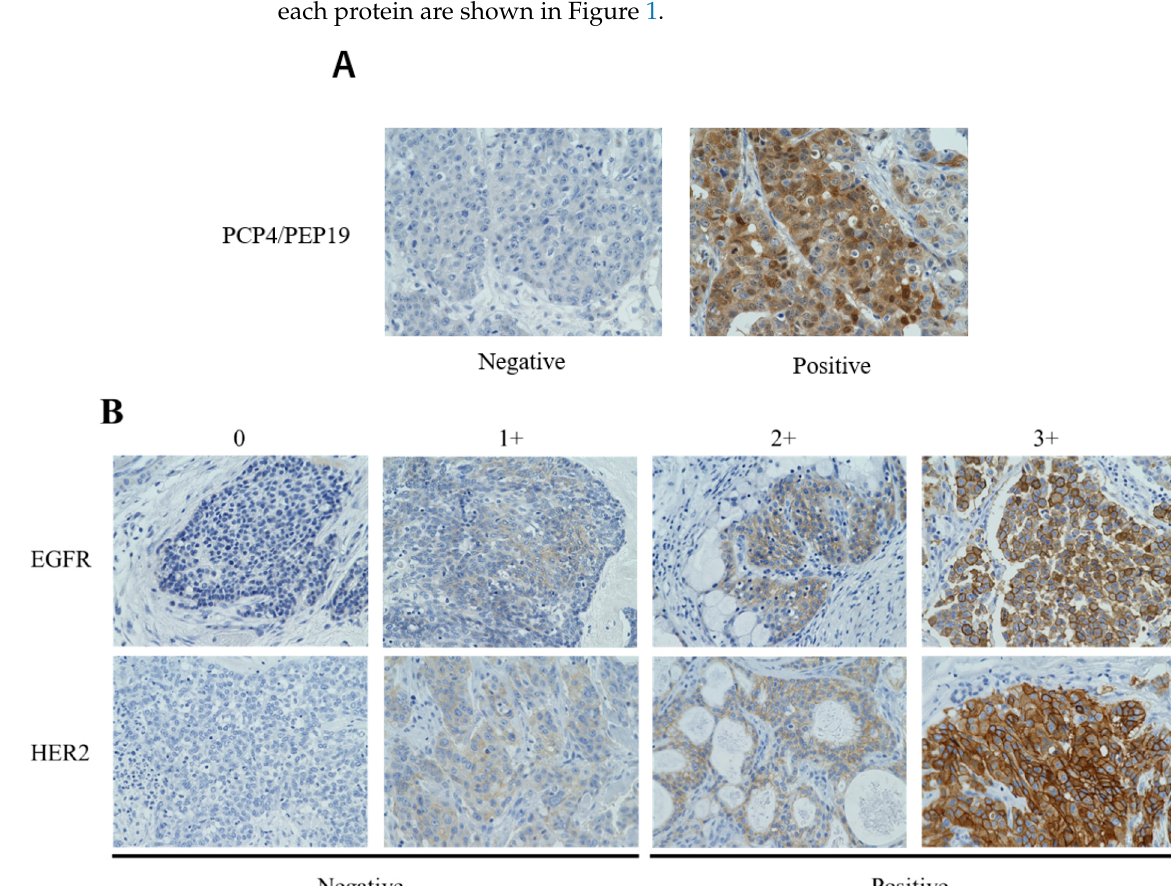
Figure 1. Representative immunohistochemical staining of PCP4/PEP19. ( A ) EGFR and HER2; ( B ) expression in MECs. PCP4/PEP19 expression was judged to be positive if cytoplasmic and nucleic staining was observed in 1% or more of tumor cells. The criteria of positive expression for HER2 were determined by reference to previous reports; that is, the score was divided into four categories (0, 1+, 2+, 3+) according to the membrane staining of tumor cells, and a score of 2+ or more was judged to be positive. Purkinje cell protein 4 (PCP4)/peptide (PEP) 19, brain-specific polypeptide; EGFR, epidermal growth factor receptor; HER2, human epidermal growth factor receptor type 2; MEC, mucoepidermoid carcinoma.